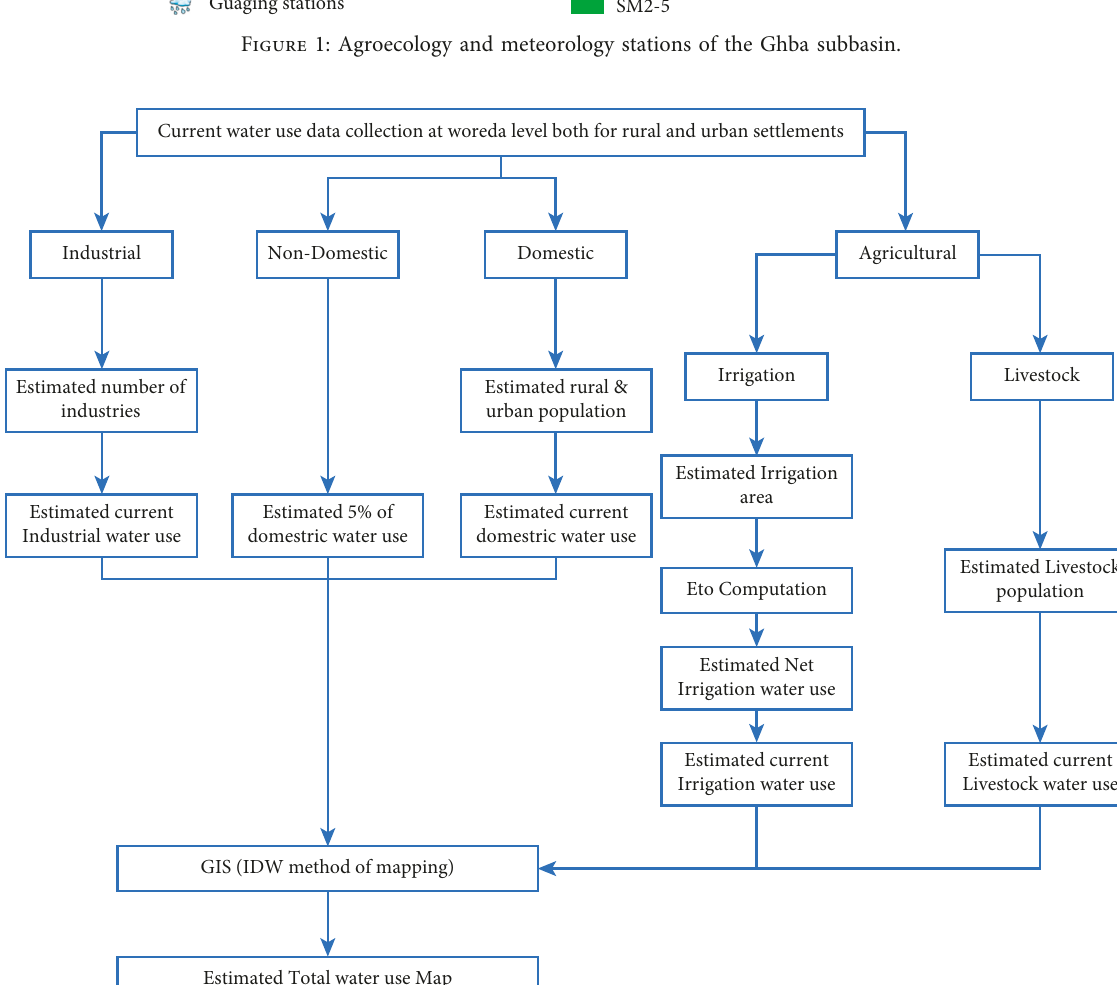
Figure 2: Flow chart of total current water use estimation and mapping